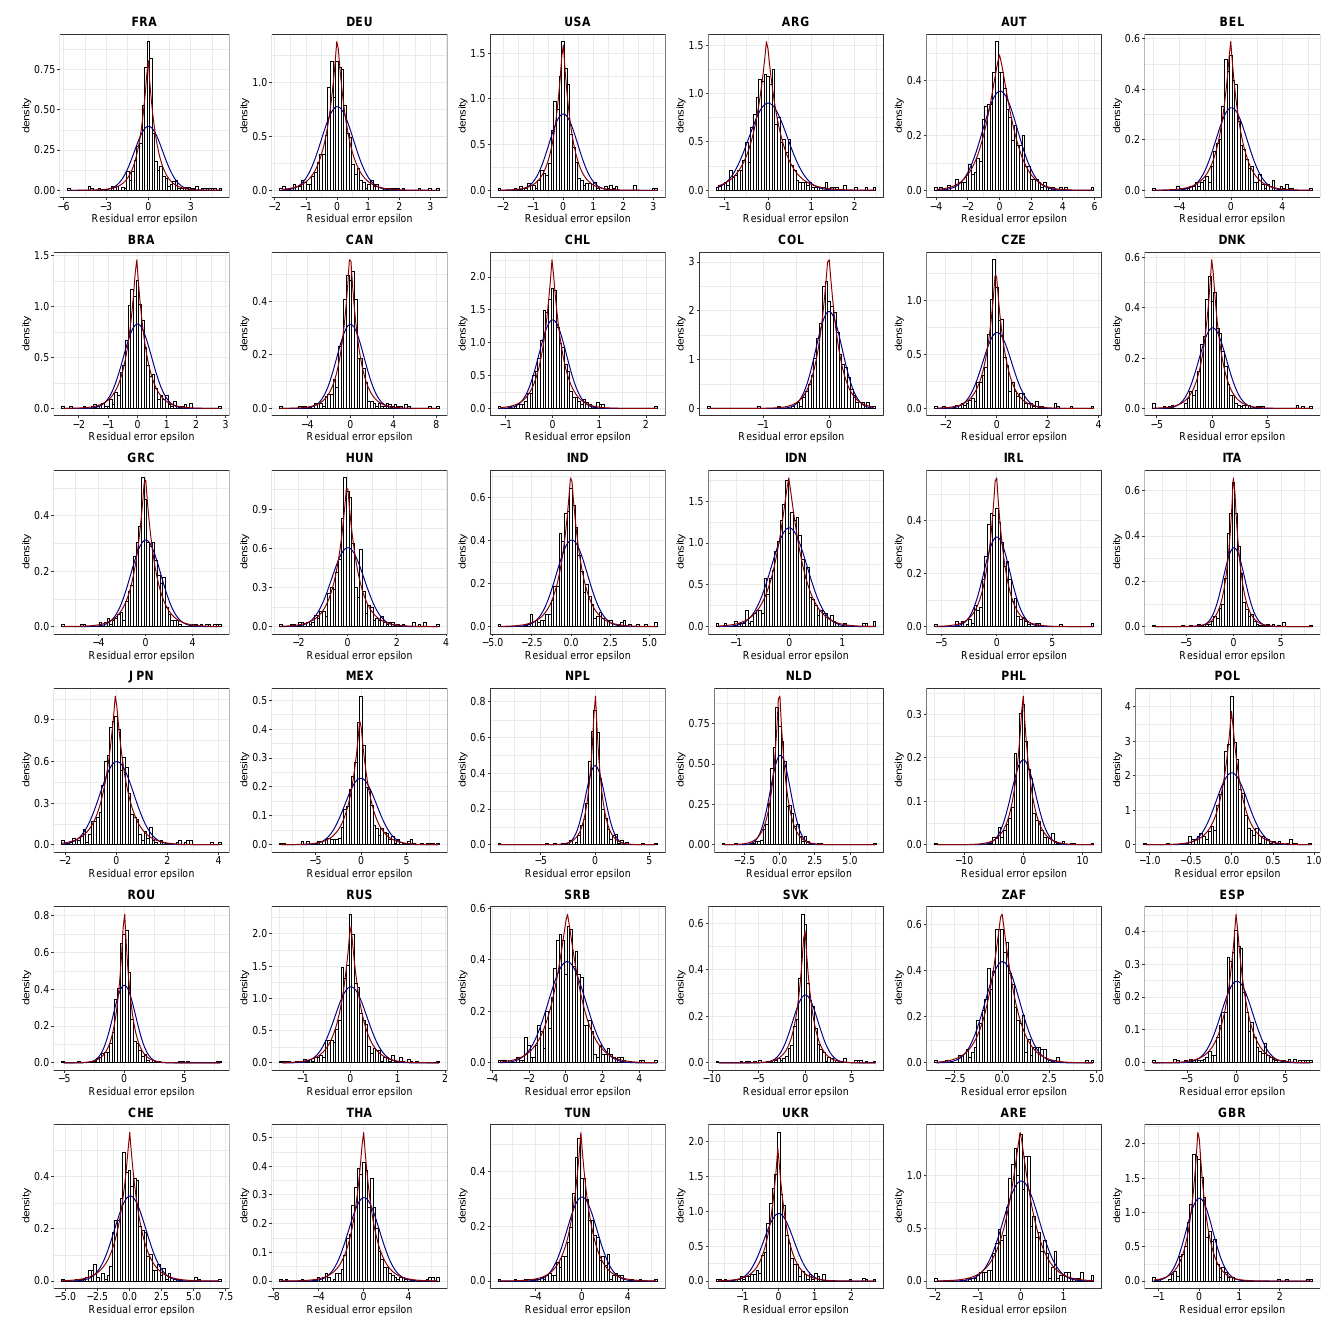
Figure A4. Fit of exponential distributions for 36 countries. In red, the best fitting exponential distribution with shape larger or equal to 1. In black, the best fitting normal